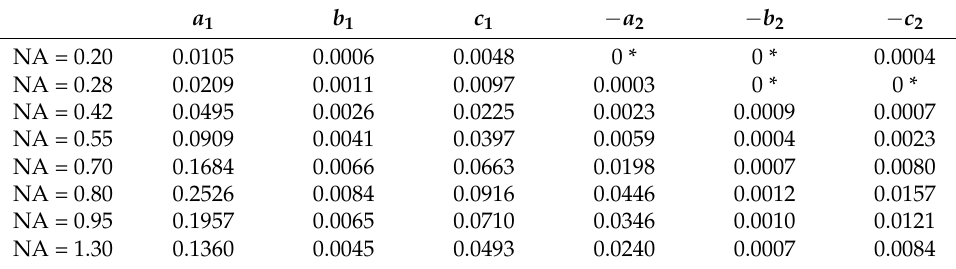
Table 2. Coefficients a 1 , b 1 , c 1 , a 2 , b 2 , and c 2 values for different NAs.